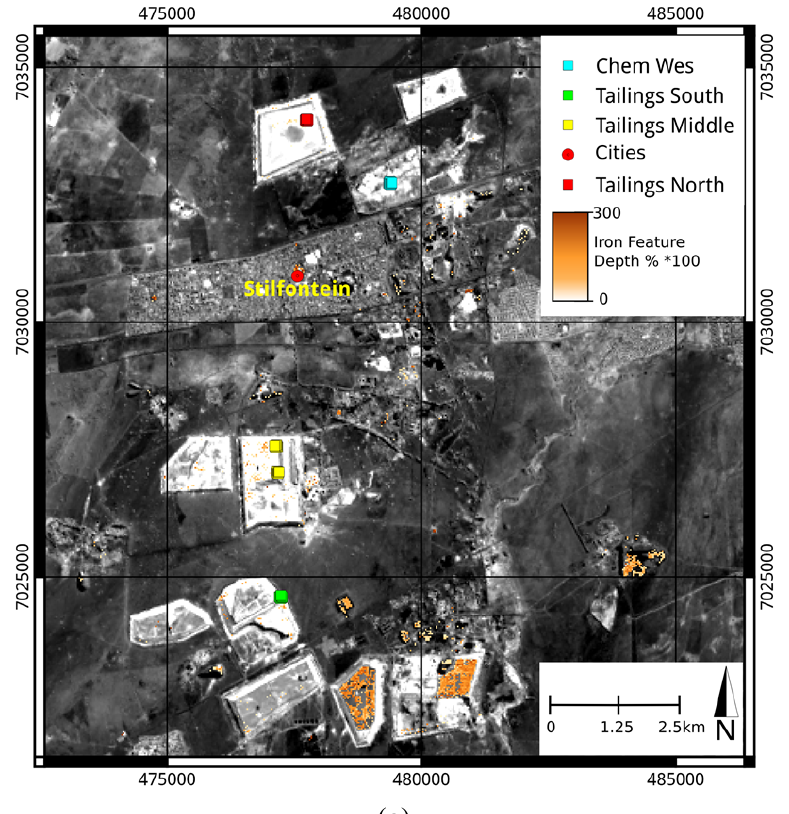
Figure 8. Iron feature depth for the tailings areas near Klerksdorp (Stilfontein) calculated from OLI data and overlain on the grayscale NIR channel of OLI ( a ), directly below. Note the lesser spatial resemblance between the mica analysis in Figure ( b ) and the IFD image (a). USGS MICA analysis from Hyperion data for the tailings areas near Klerksdorp (Stilfontein) overlain on the gray-scaled NIR channel of OLI (b). The yellow box outlines an area that is affected by the presence of secondary iron